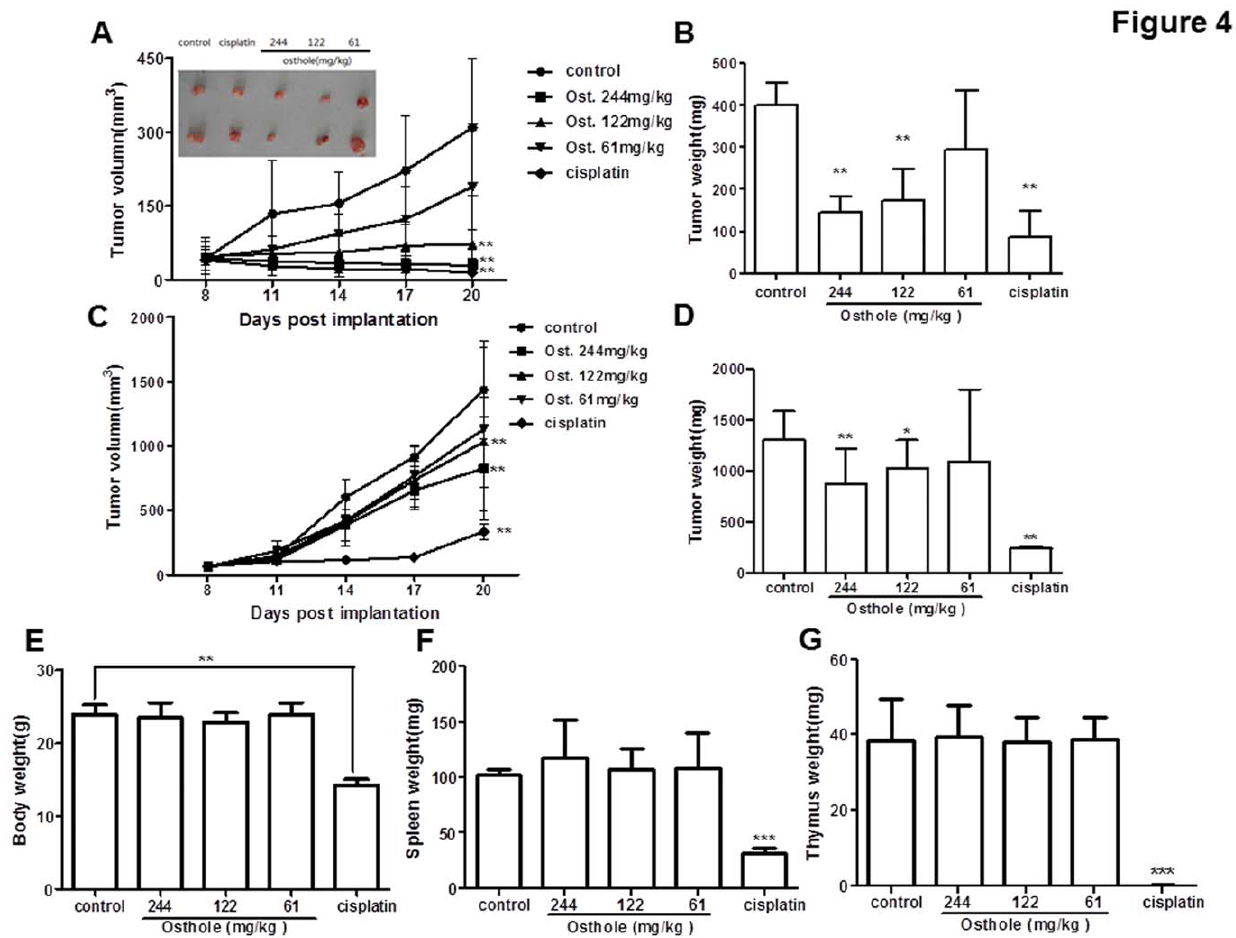
Figure 4. Effect of Osthole Treatment on the Tumorigenicity of HCC Cells. A total of 2 6 10 6 SMMC-7721 or Hepa1-6 cells were inoculated subcutaneously (s.c.) into the right flank of nude mice or C57/BL6 mice. Mice were randomized into five groups including osthole treatment (244 mg/ kg, 122 mg/kg and 61 mg/kg), corn oil alone as the blank control and cisplatin (5 mg/kg) as the positive control on Day8 and were treated once every other day for 2 weeks. (A) The tumor volumes of the nude mice inoculated with SMMC-7721 cells were measured and calculated once every three days. The tumor sizes on day 21 were shown in the inserted figure. (B) Tumor weights of the nude mice inoculated with SMMC-7721 cells were measured on day21. (C) The tumor volumes of the C57/BL6 mice inoculated with Hepa1-6 cells were measured and calculated once every three days. (D) Tumor weights of the C57/BL6 mice inoculated with Hepa1-6 cells were measured on day21. (E) The body weights of nude mice inoculated with SMMC-7721 cells were weighed on day 21. The (F) spleen weights and (G) thymus weights of the C57/BL6 mice inoculated with Hepa1-6 cells were weighed on day21. Each data point represented the mean 6 S.D. of 10 mice. Data shown were the representatives of three experiments.